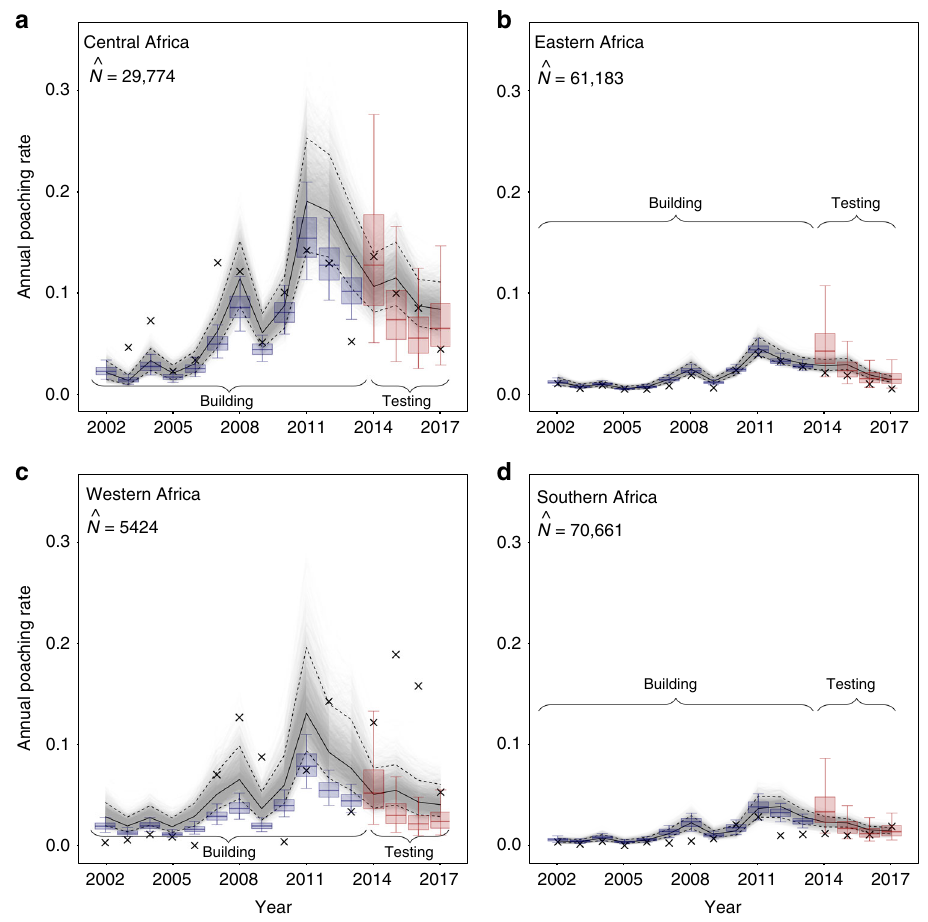
Fig. 4 Region-speci fi c annual estimates of per capita poaching rates. Displayed estimates are annual median poaching rates across the sites and years within a Central Africa, b Eastern Africa, c Western Africa and d Southern Africa, each derived from 3000 MCMC samples. Grey lines display estimates from the model fi tted to all data, with solid black line showing median estimates and dashed lines outlining 90% CIs. Blue boxes represent estimates from the model (same structure) fi tted to training data (2002 – 13) only, red colour highlights estimates for test data (2014 – 17). Boxplot centre lines represent median estimates, box bounds fi rst and third quartiles, and whiskers 90% CIs. Crosses represent overall observed poaching rate across the sites within the respective region and will be biased towards sites where more carcasses are found. ^ N represents the sum of the latest population size estimates over all sites within the respective region